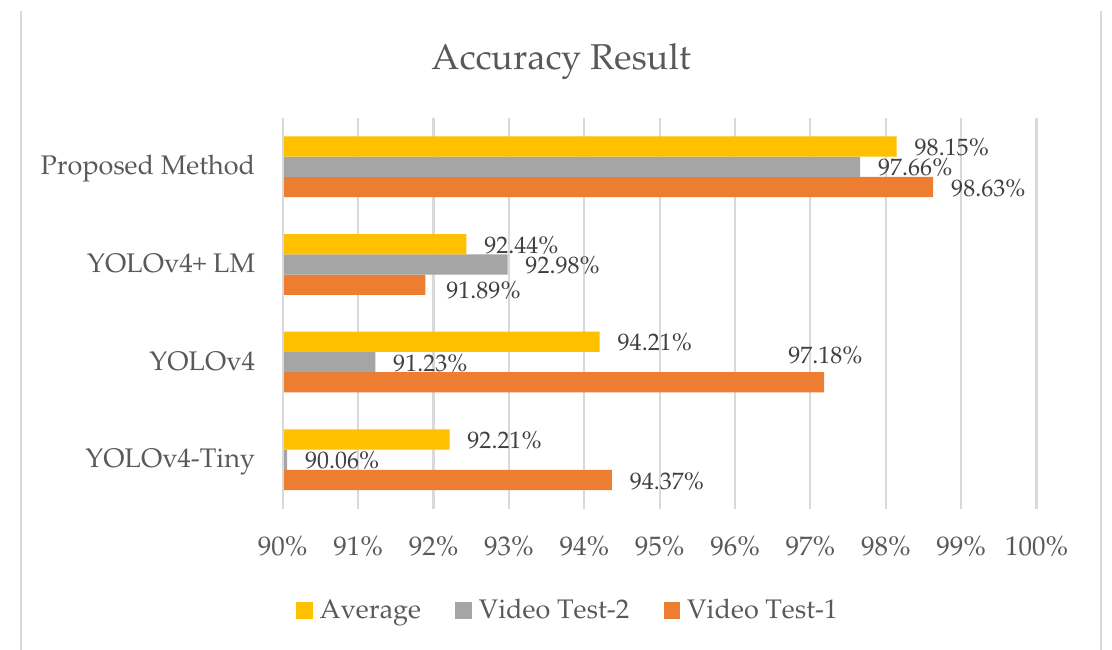
Figure 9. Experimental results (other performance parameters).